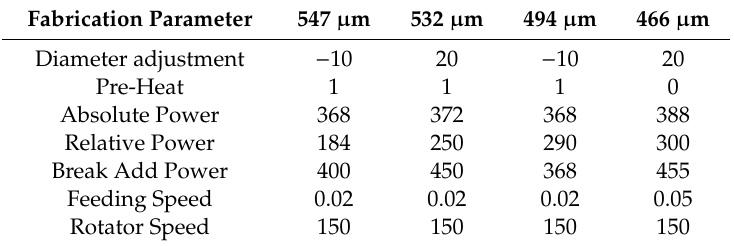
Table 1. Parameters used for fabrication of ball resonators with diameters of 547, 532, 494, and 466 µ m.